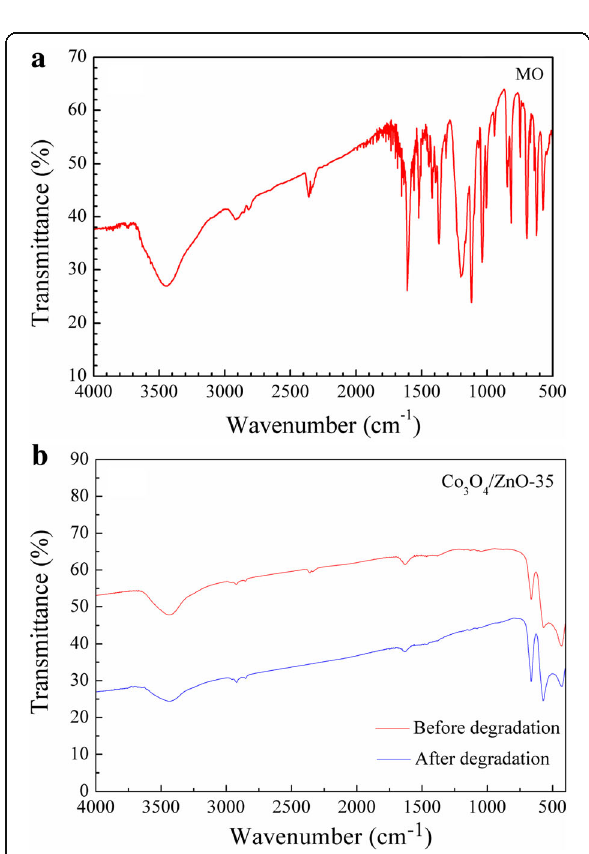
Fig. 16 FTIR spectra of a MO, b Co 3 O 4 /ZnO-35 heterostructure after 72 h degradation of